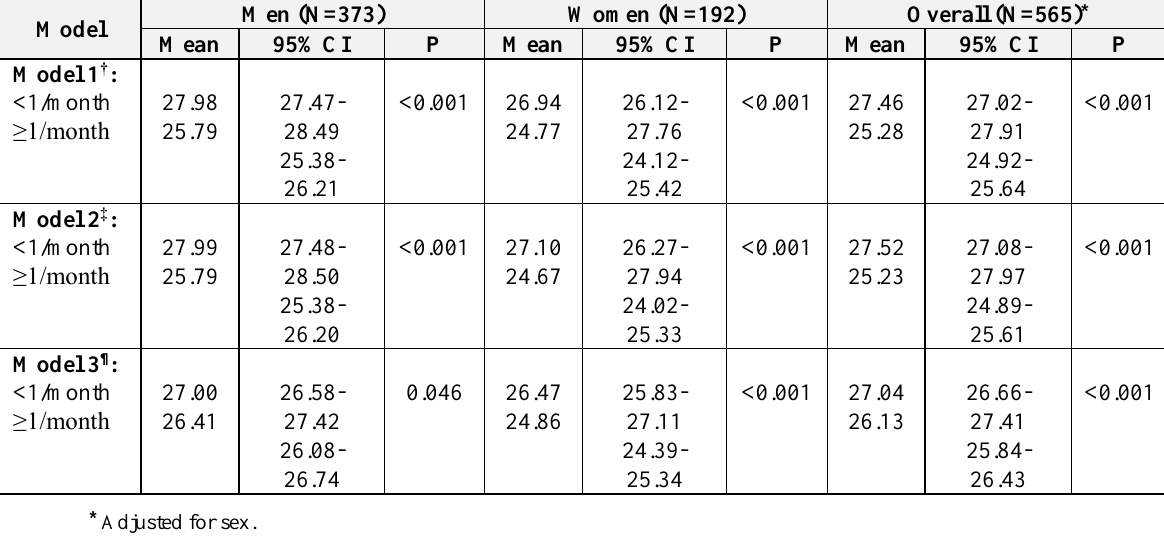
mean BMI values by sex